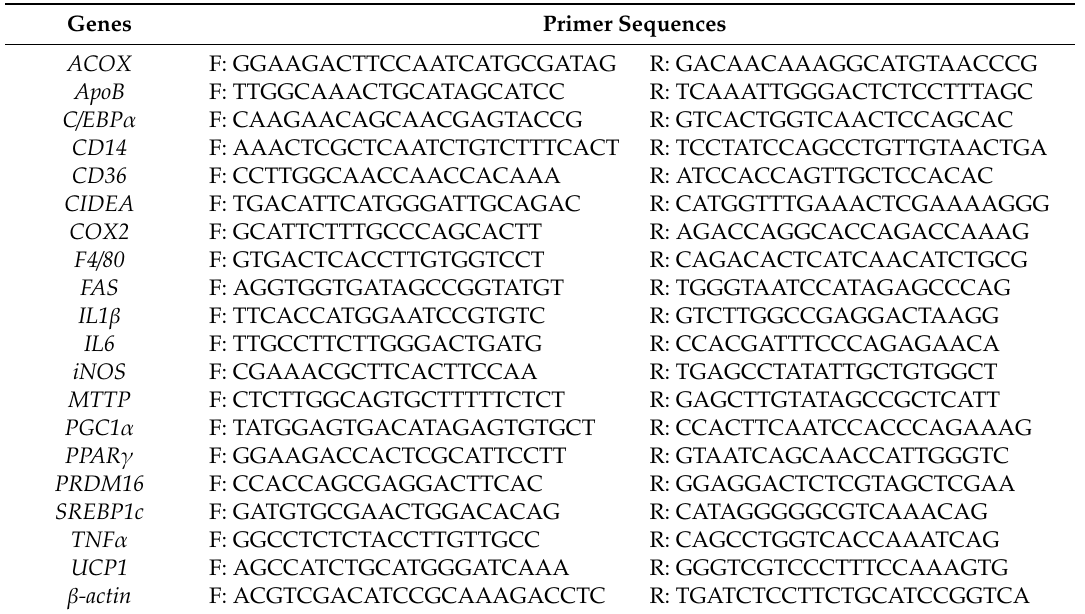
Table 1. List of primers used for